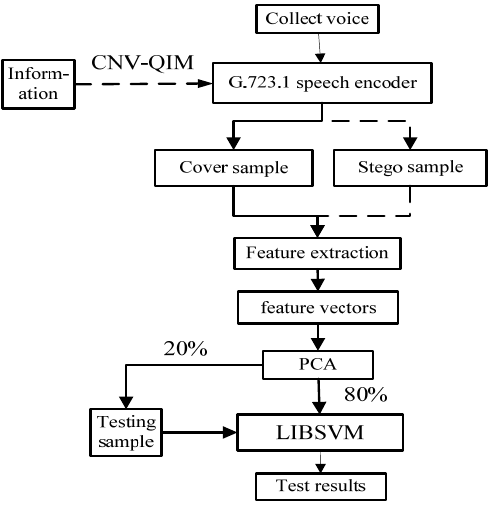
Figure 6. Steganalysis process.